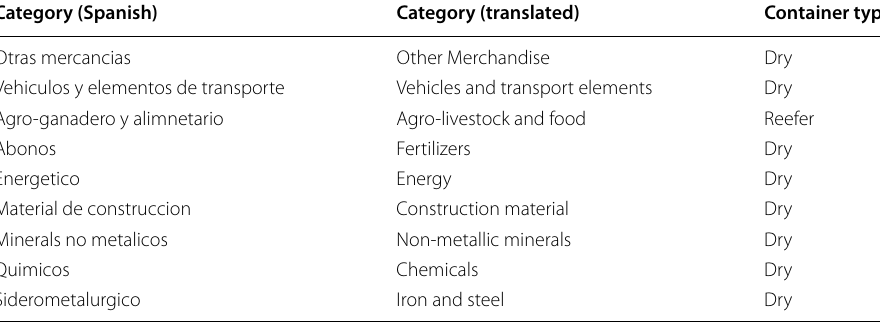
Source: Own elaboration and data based on Port of Las Palmas publications, 2017–18 Table 5 Split of dry and reefer container volumes Origin